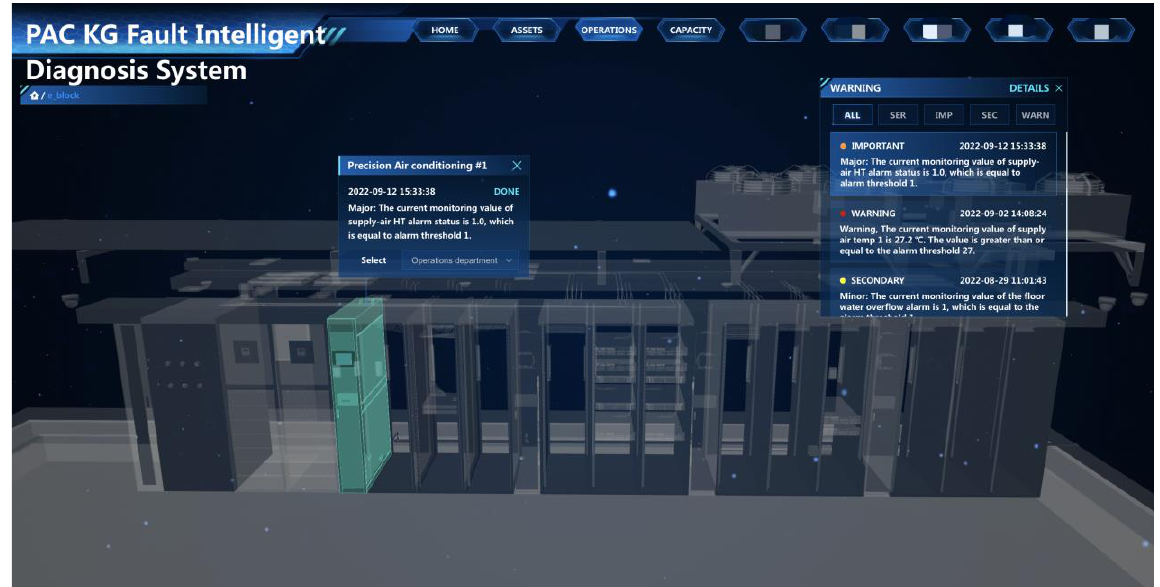
Figure 9. Precision Air Conditioning Troubleshooting Application Interface for Data Center at the Edge of Guangdong Campus in China.